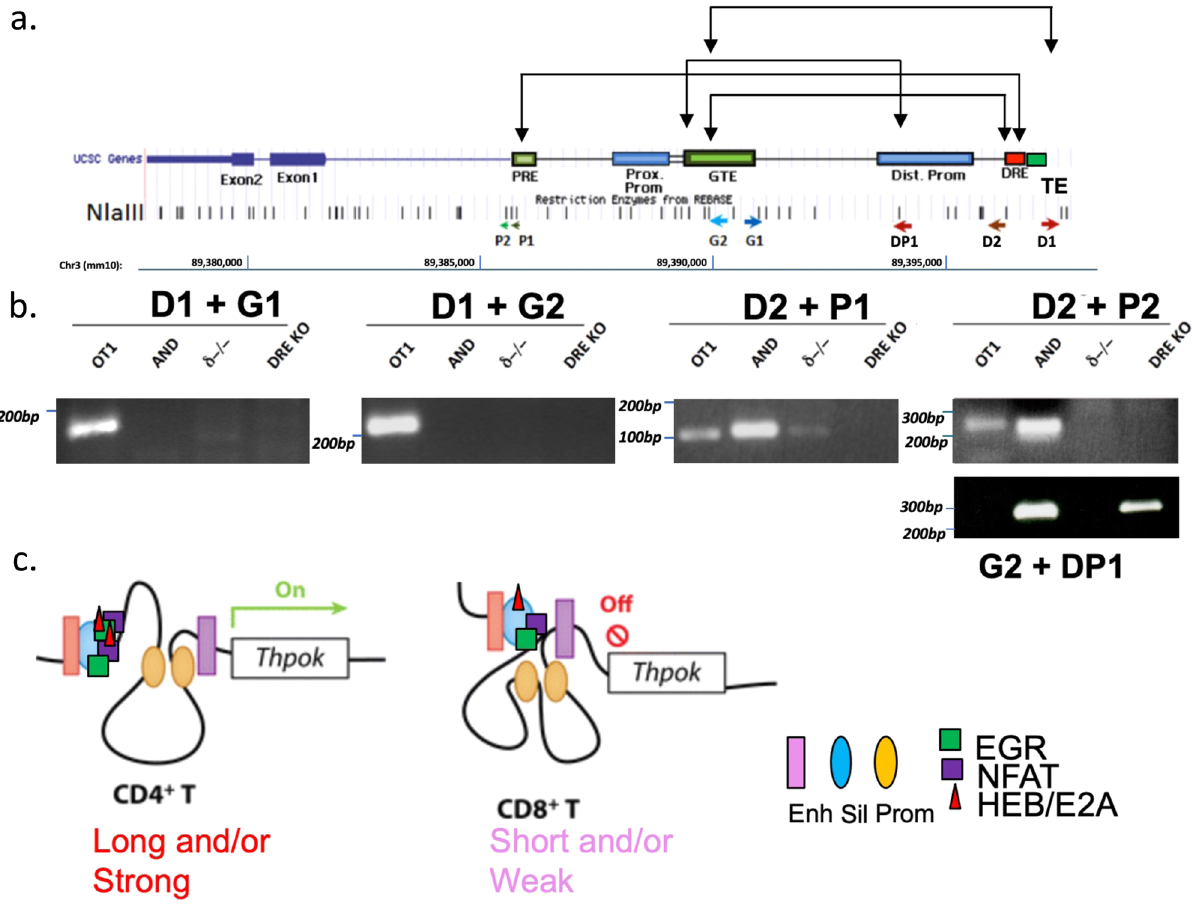
Fig. 10 Chromosome conformation capture (3C) reveals altered proximity of Sil ThPOK with other ThPOK cis elements in MHC class I- versus class II- restricted thymocytes. a Schematic of ThPOK gene organization showing exons (dark blue boxes), promoters (light blue boxes), enhancers (green boxes), and silencer (red box). Arrowheads at bottom of the panel indicate the position/orientation of PCR primers, while connected arrows at top of the panel show different primer combinations that were utilized. b 3C analysis of physical interactions of Sil ThPOK with other ThPOK cis elements in total thymocytes from AND Tg + (class II-restricted), OT-1 Tg + (class I-restricted), CD3 δ − / − (uncommitted; blocked at DP stage), and ThPOK Δ Sil (DRE knockout) mice, respectively. N = 3 independent animals per strain. c Model of proposed ThPOK cis element interactions in class I- versus class II-restricted